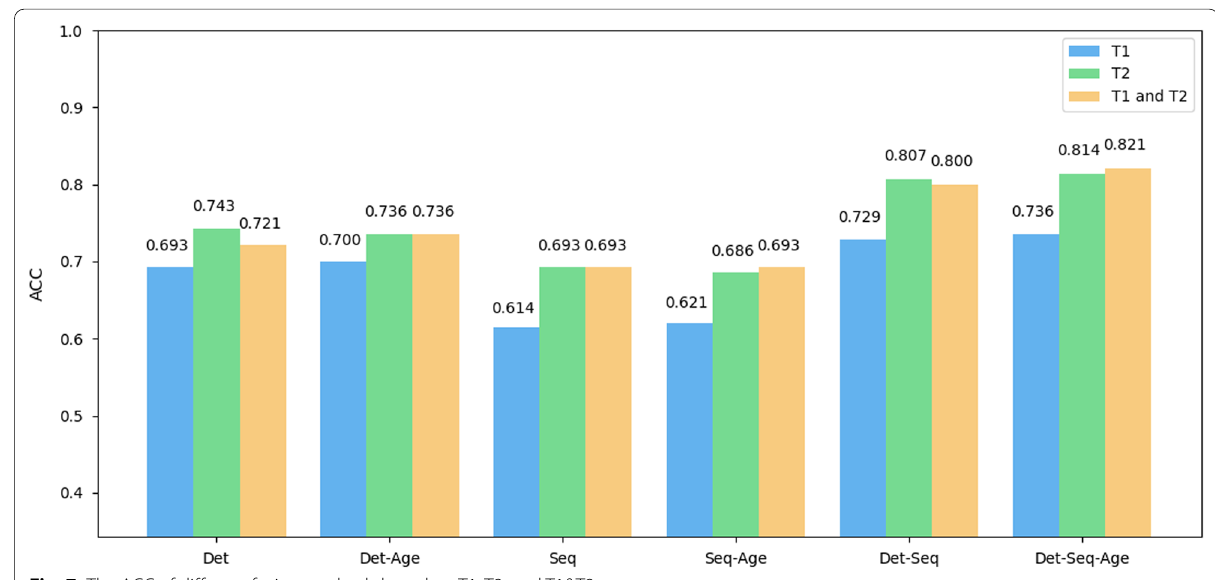
Fig. 7 The ACC of different fusion methods based on T1, T2, and T1&T2